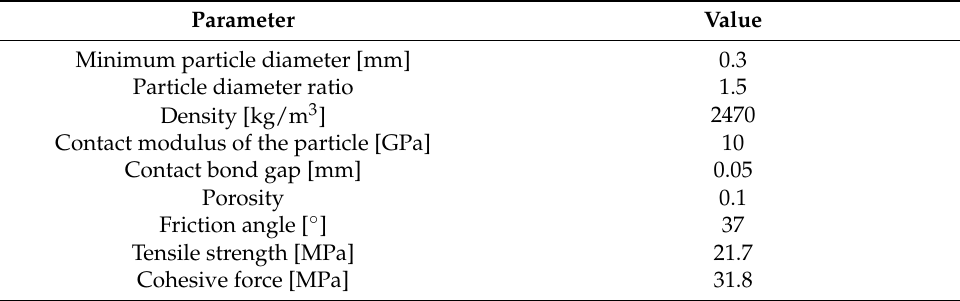
Table 2. The microscopic parameters.